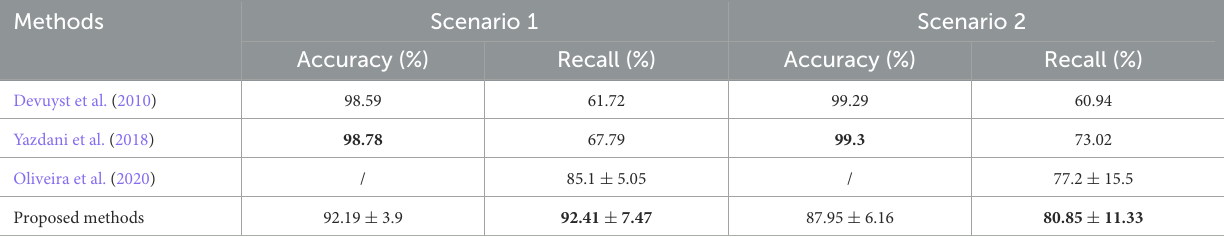
TABLE 5 Performance comparisons between the proposed method and other existing methods for Scenarios 1 and